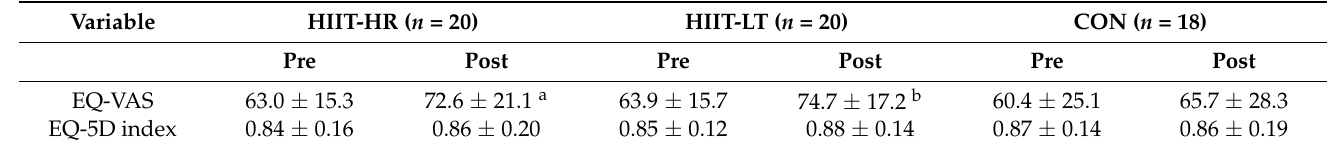
Table 6. Quality of life